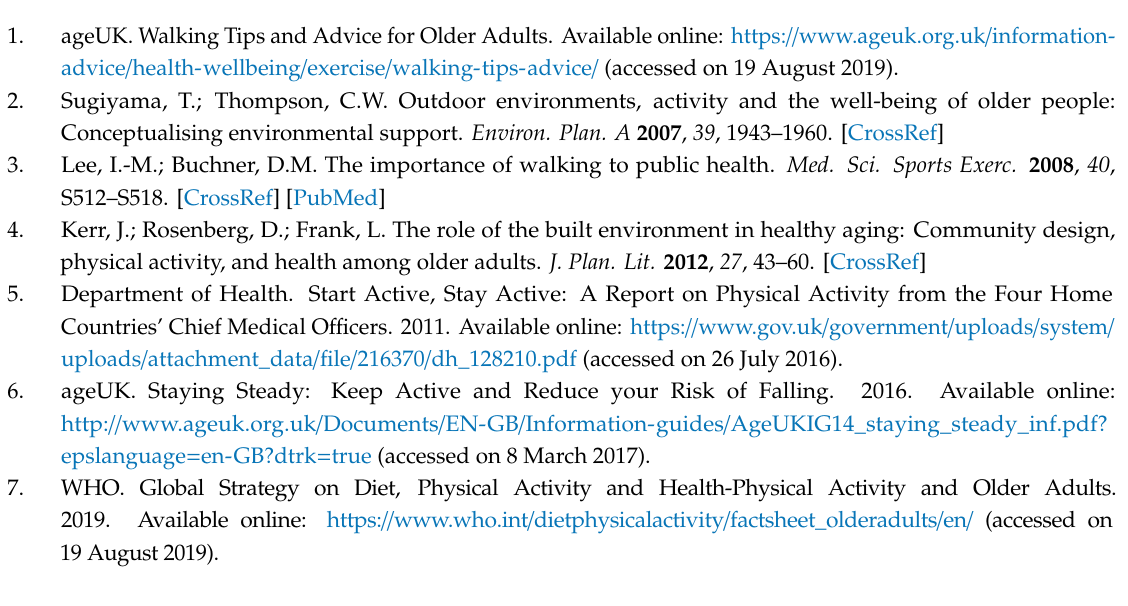
Table S1: Correlations between characteristics of three types of neighbourhood green spaces (i.e., the closest, most attractive, and largest); Table S2: Correlations between participants’ personal characteristics and characteristics of three types of neighbourhood green spaces (i.e., the closest, most attractive, and